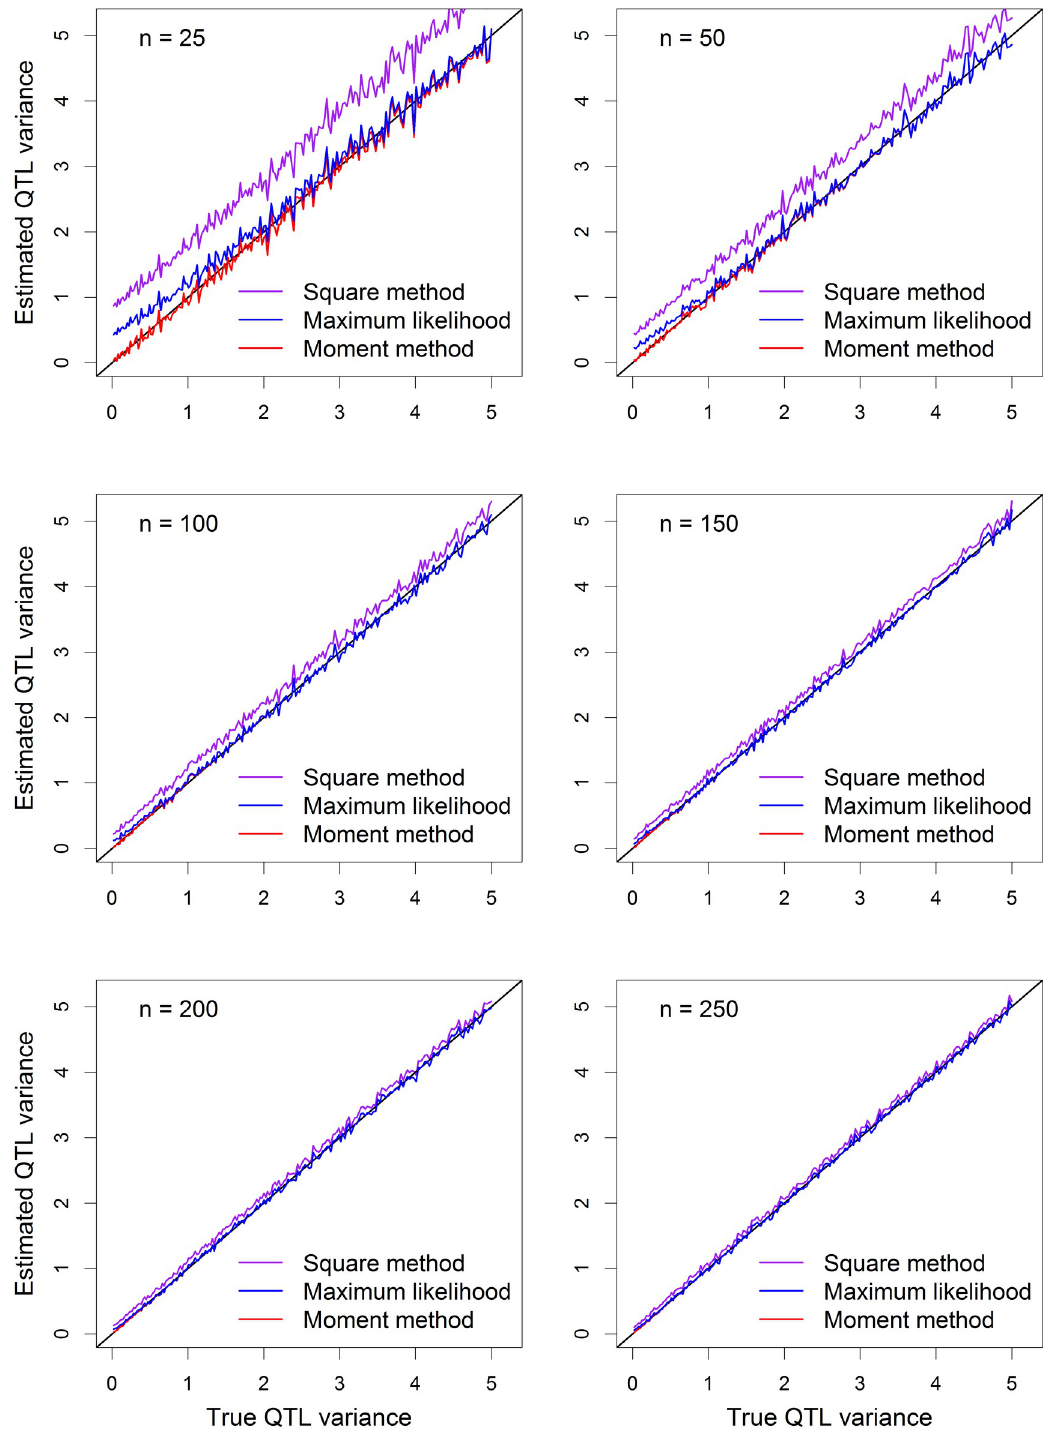
Fig 2. Plots of estimated QTL variances from three methods against the true QTL variance. The six panels of the figure show the results of six different sample sizes ( n ), which are 25, 50, 100, 150, 200 and 250, respectively.